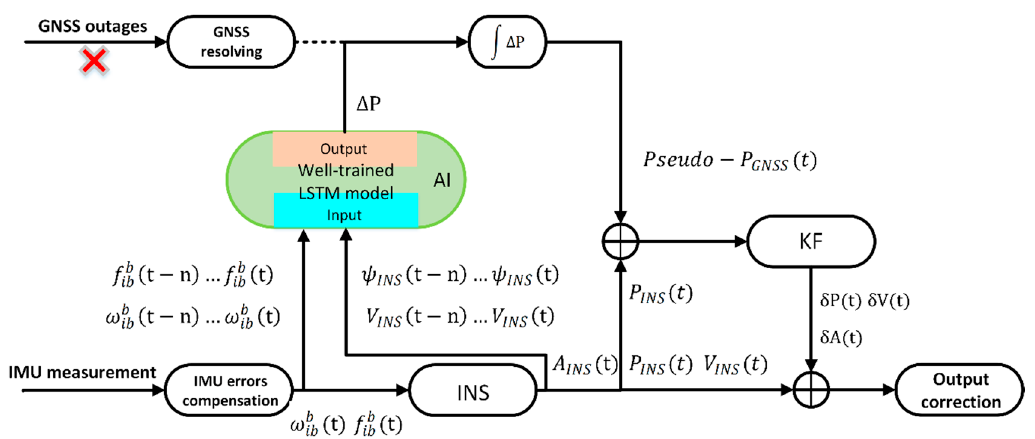
Figure 5. Block of the predicting. Figure 4. Block of the training. Figure 4. Block of the training.